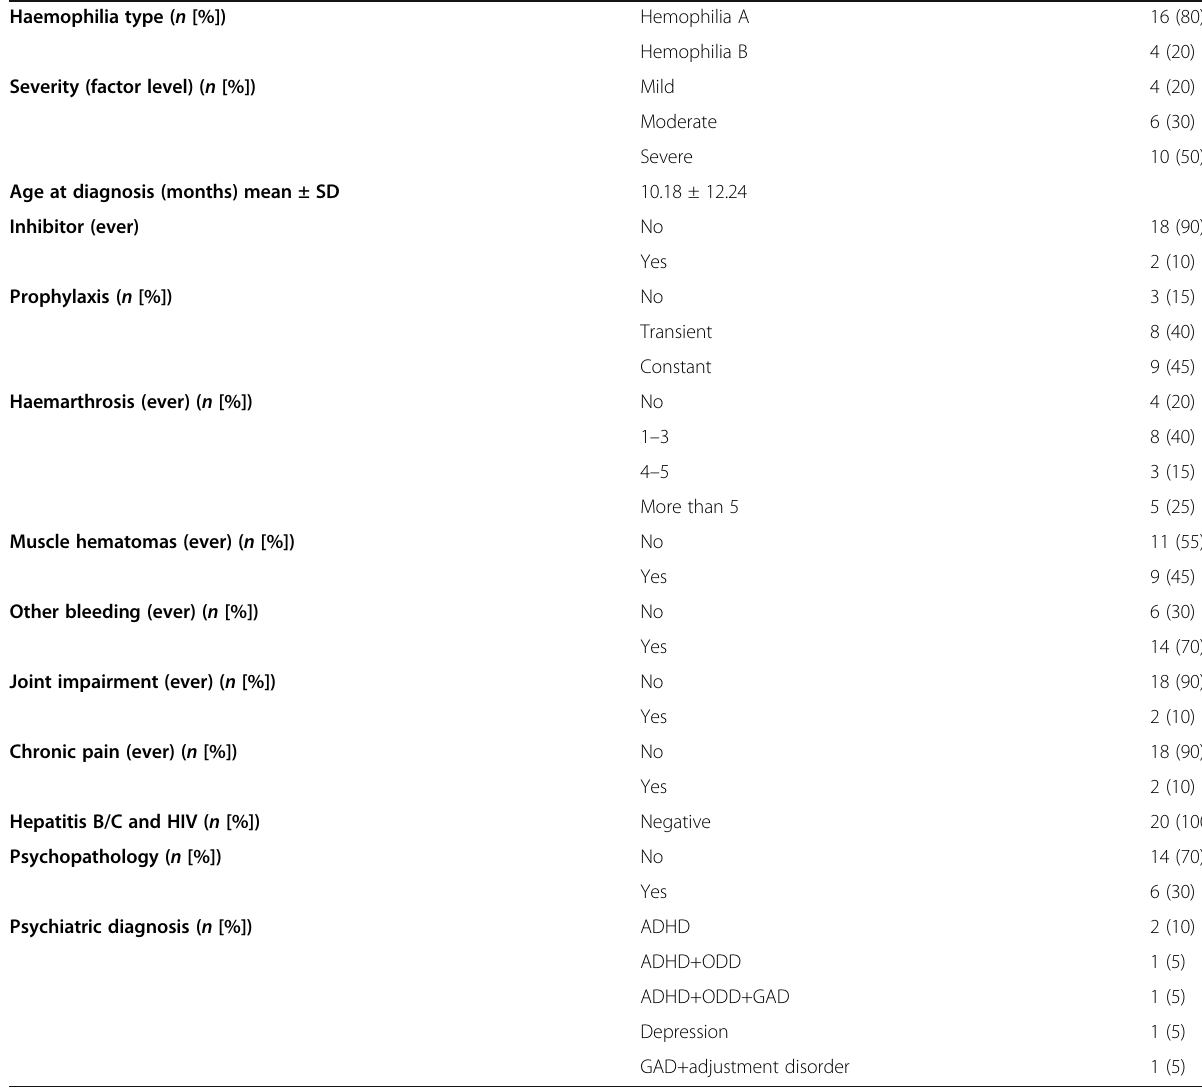
Table 2 Clinical variables of children and adolescents with hemophilia Haemophilia type ( n [%]) Hemophilia